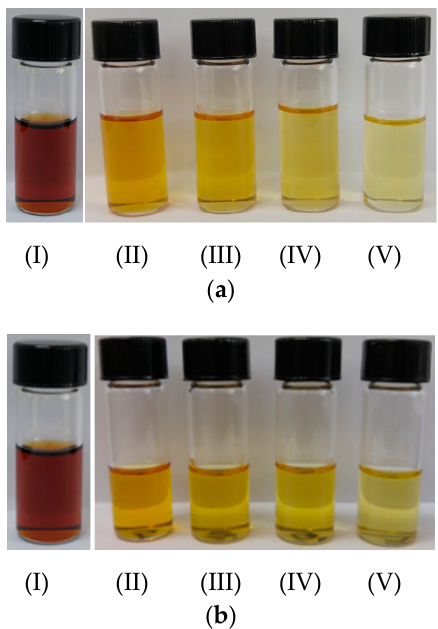
Figure 5. Comparison of solvent for color change in raffinate according to (S/F) 0 . Solvent used: ( a )